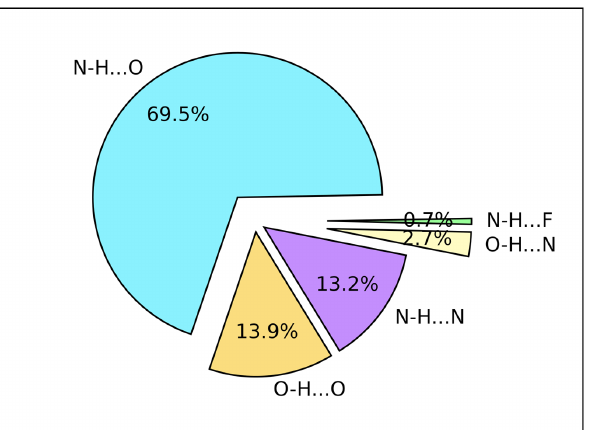
Figure 3. Hydrogen bond type frequencies in database A as X–H · · · Y, where X is the hydrogen bond donor, and Y is the hydrogen bond acceptor (in